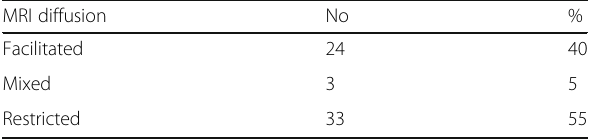
Table 4 Distribution of MRI diffusion among studied group MRI diffusion